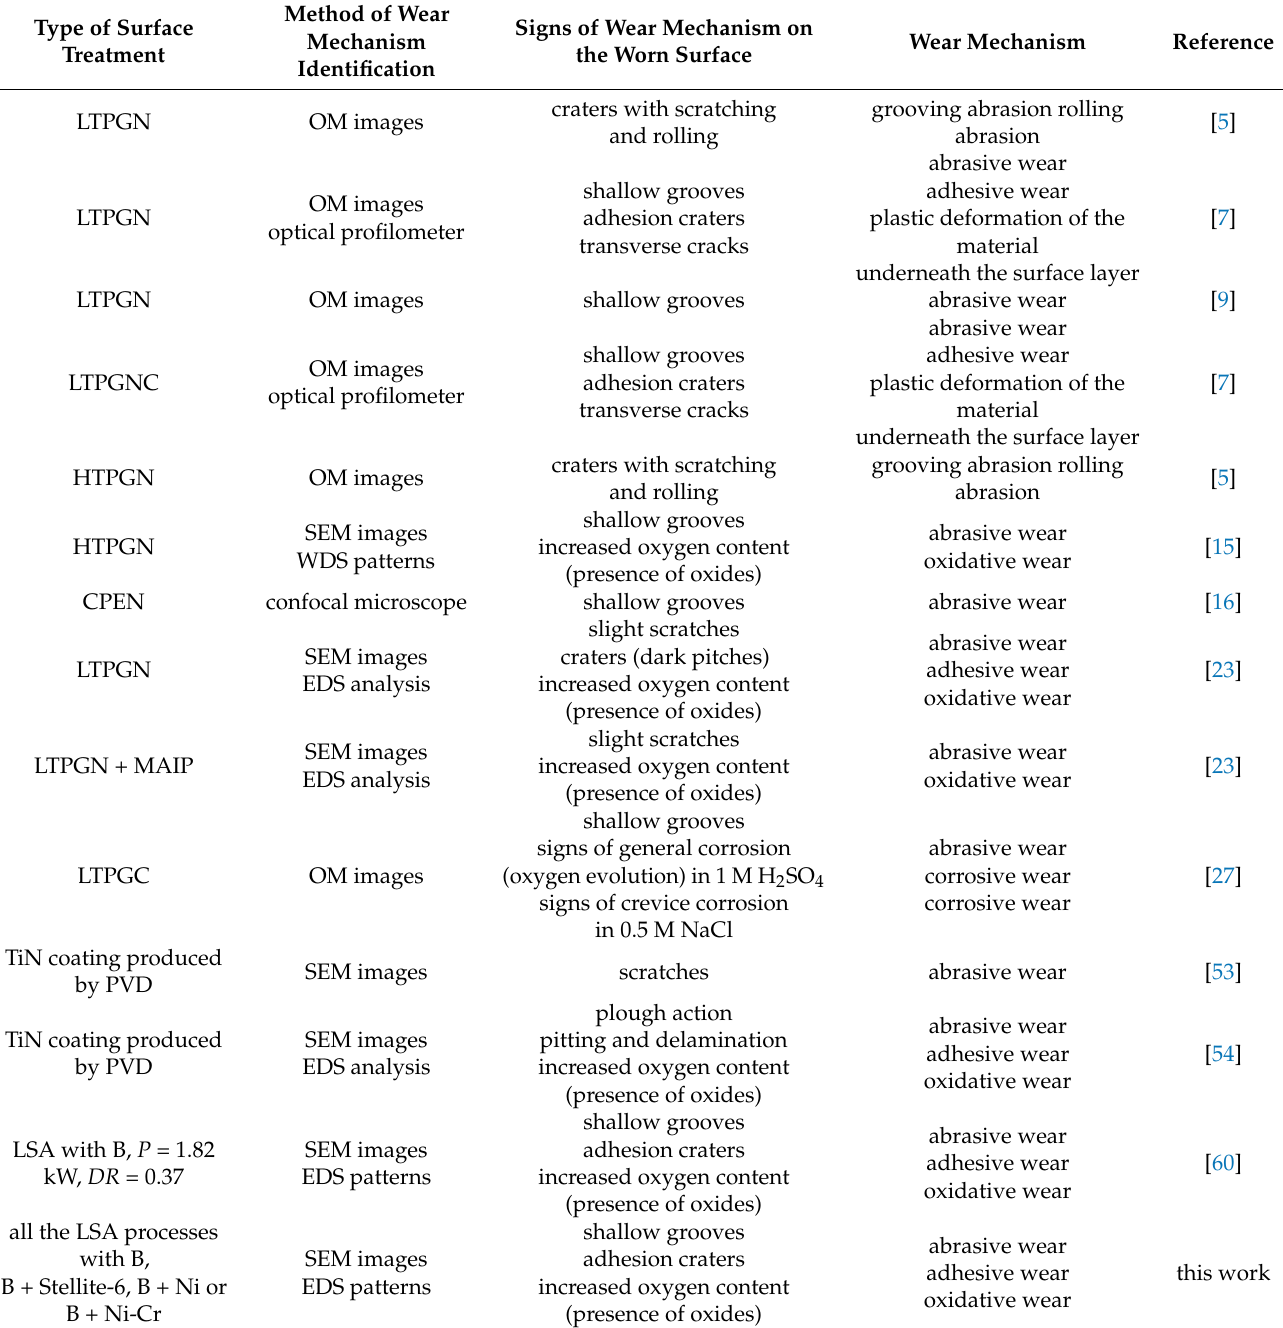
Table 5. Wear mechanisms of the surface layers produced by various physical